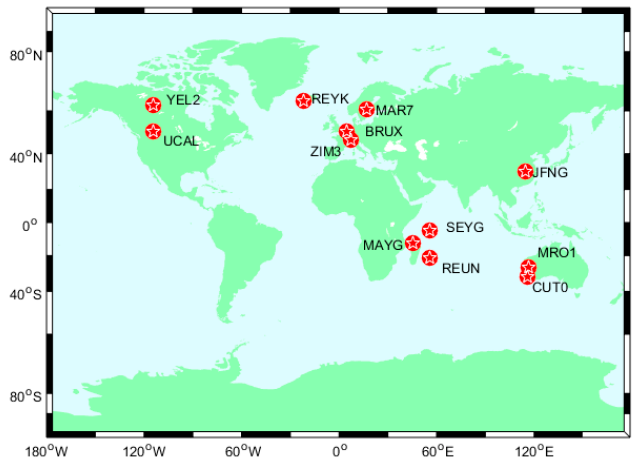
8 of 20 Table 1. Summary of observation model and data processing strategies for SPP and PPP. Item